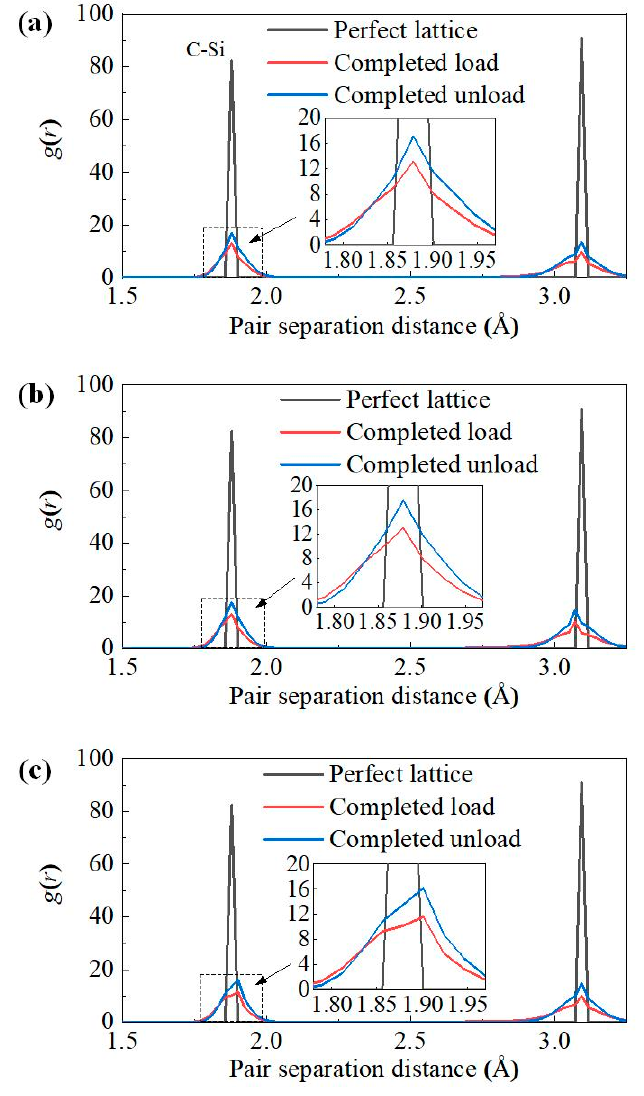
Figure 4. Pair correlation analysis for three types of SiC single crystal. ( a ) 3C-SiC, ( b ) 4H-SiC, and ( c ) 6H-SiC, respectively.